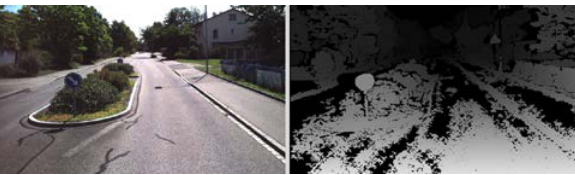
Figure 8. Disparity map without enhancement (left = original image, right = disparity map)